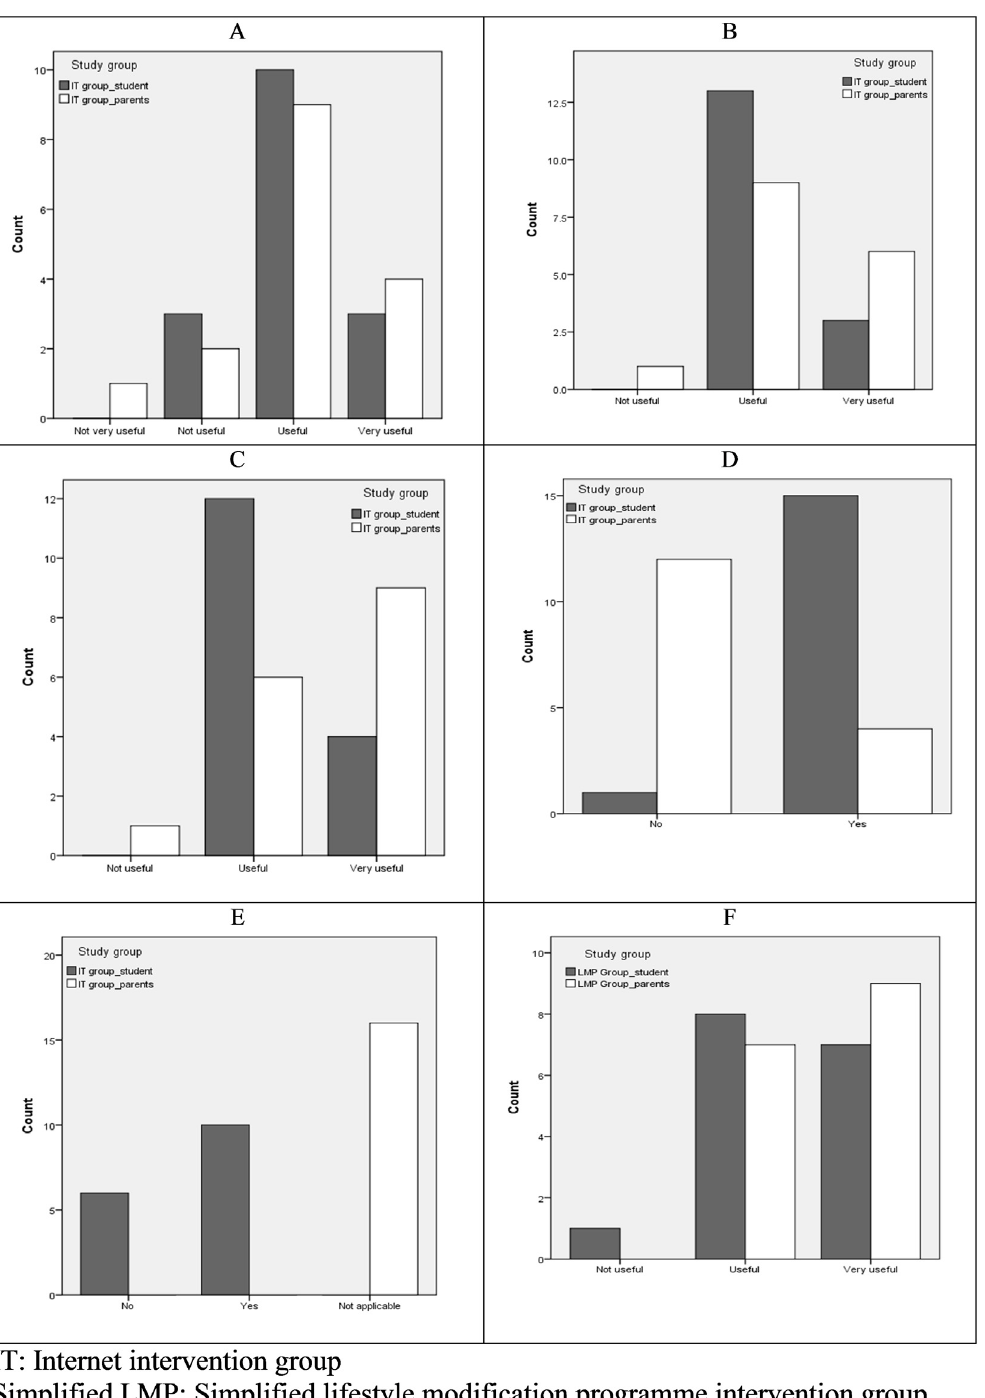
Fig 2. Participation rates and satisfaction levels of intervention subjects at final visit (week 24). Satisfaction levels of subjects in the internet intervention group (IT) regarding the internet curriculum (A), cell phone communication (B), goal setting (C) and IT subjects ’ log-in (D) and curriculum completion rates (E) for online curriculum at final visit (week 24). Satisfaction levels of subjects in simplified lifestyle modification programme (sLMP) group with nutritional counselling at final visit (F).